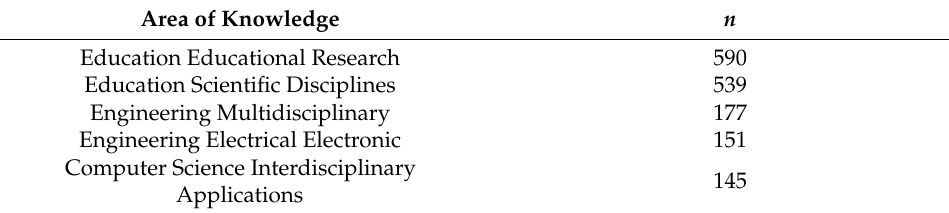
Table 3. Areas of Table 3. Areas of knowledge.